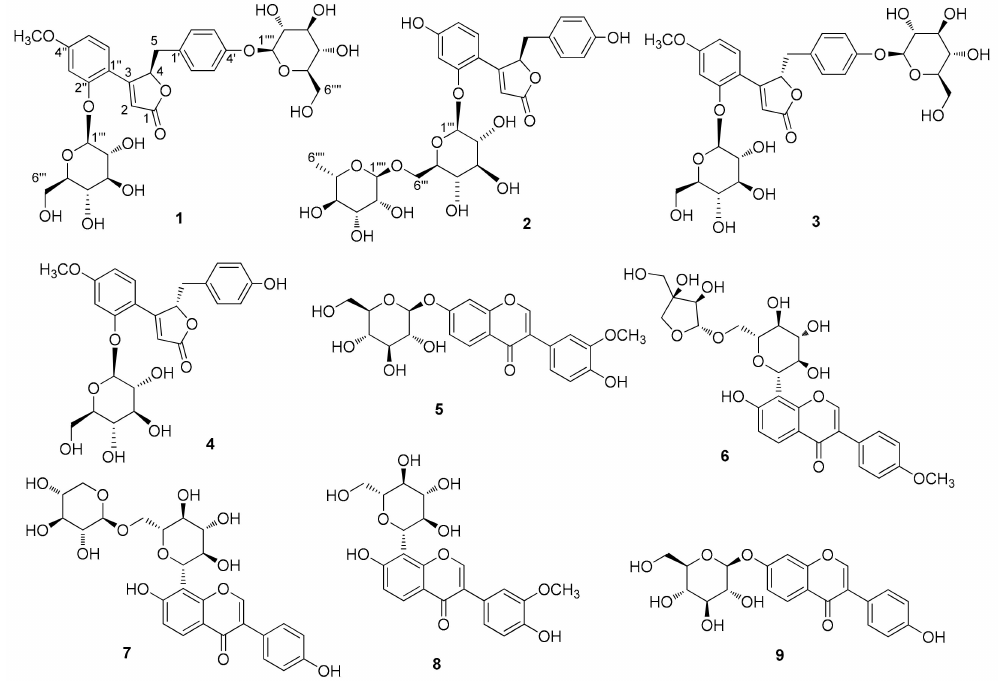
Figure 1. Structures of compounds 1 – 9 isolated from P. lobata